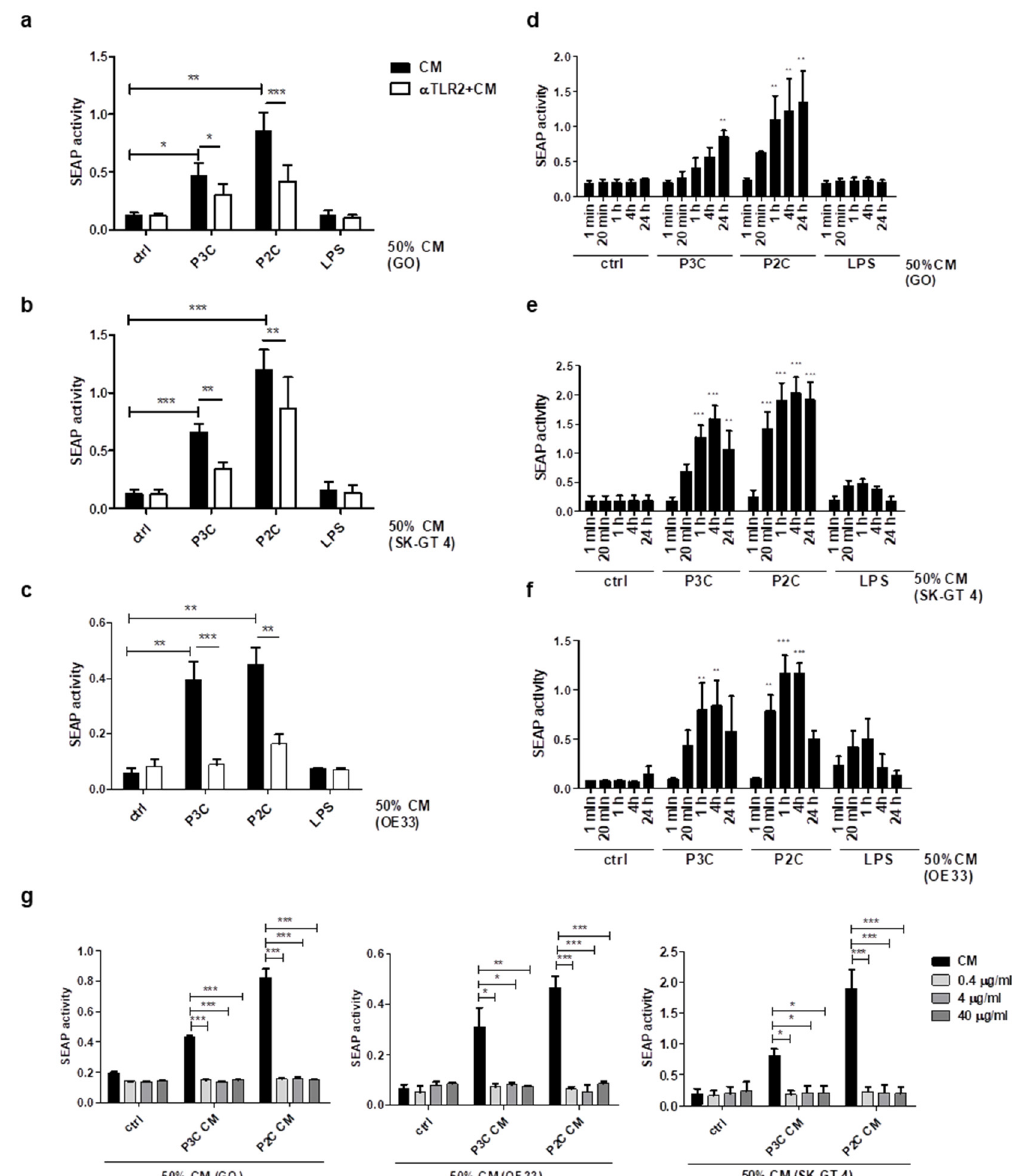
Figure 4. Oesophageal cell lines secrete TLR agonists following TLR2 stimulation. ( a – c ) Oesophageal cells (GO, SK-GT 4 and OE33) were α TLR2 (10 µ g/mL) pre-treated for 1 h prior to stimulation (4 h) with P3C (0.05 µ g/mL), P2C (0.05 µ g/mL) or LPS (1 µ g/mL). The medium was removed, cells were washed x3 with PBS and incubated in fresh media for 24 h. Conditioned medium (CM) was collected from ( a ) GO; ( b ) SK-GT 4; and ( c ) OE33 cells and added (50% final conc.) to the TLR reporter cell line THP1-XBlue-CD14 (seeded at 4 × 10 6 cells/mL) for 24 h. TLR stimulation was assessed by measuring supernatant SEAP levels, using QUANTI-Blue reagent. Statistical analysis was performed using an unpaired two-tailed Student’s t -test to compare the mean ± SEM values between untreated and CM treated cells and two-way ANOVA to compare α TLR2-treated and -untreated cells, n = 3, * p < 0.05; ** p < 0.01; *** p < 0.001. ( d – f ) Oesophageal cells were stimulated as in ( a – c ) for 4 h. The medium was removed, cells were washed (x3) and incubated in fresh media for the timepoints indicated. CM was collected from ( d ) GO; ( e ) SK-GT 4; ( f ) OE33; and added (50% final conc.) to THP1-XBlue-CD14 cells. Values represent the mean ± S.E.M of three independent experiments; * p < 0.05; ** p < 0.01; *** p < 0.001 (Unpaired Student’s t -test). ( g ) THP1-XBlue-CD14 cells were left untreated or pre-treated (1 h) with 0.4 µg/mL; 4 µg/mL; 40 µg/mL α TLR2 prior to incubation with 50% CM collected from unstimulated, P3C- or P2C-stimulated GO, SK-GT 4 or OE33 cells. Data represent the mean ±SEM of n = 3; ** p < 0.01; *** p < 0.001 (two-way ANOVA test).